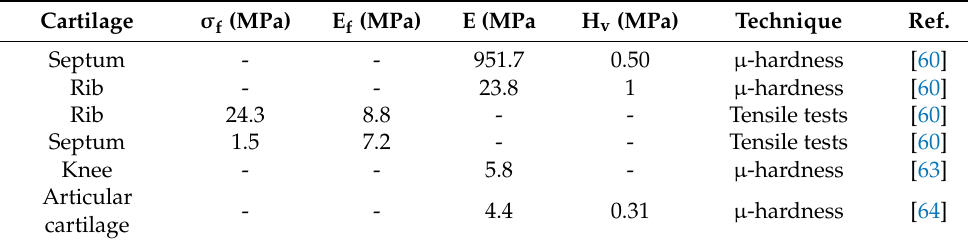
Table 6. Mechanical properties of native human